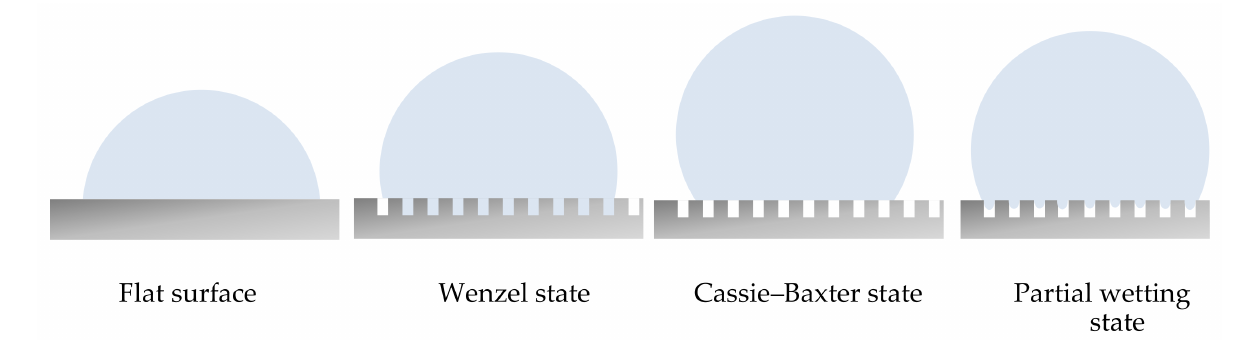
Figure 1. Wettability states in flat and rough (porous)